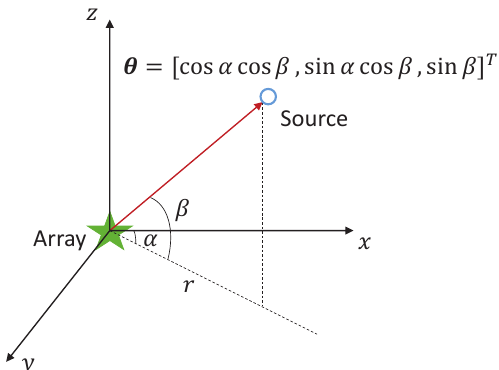
Figure 1. Geometrical relationship of direction of arrival (DOA) ( θ ) and the azimuth angle ( α ) and the grazing angle ( β ). A horizontal array is deployed at the xy plane. The horizontal distance between source and array is r km.